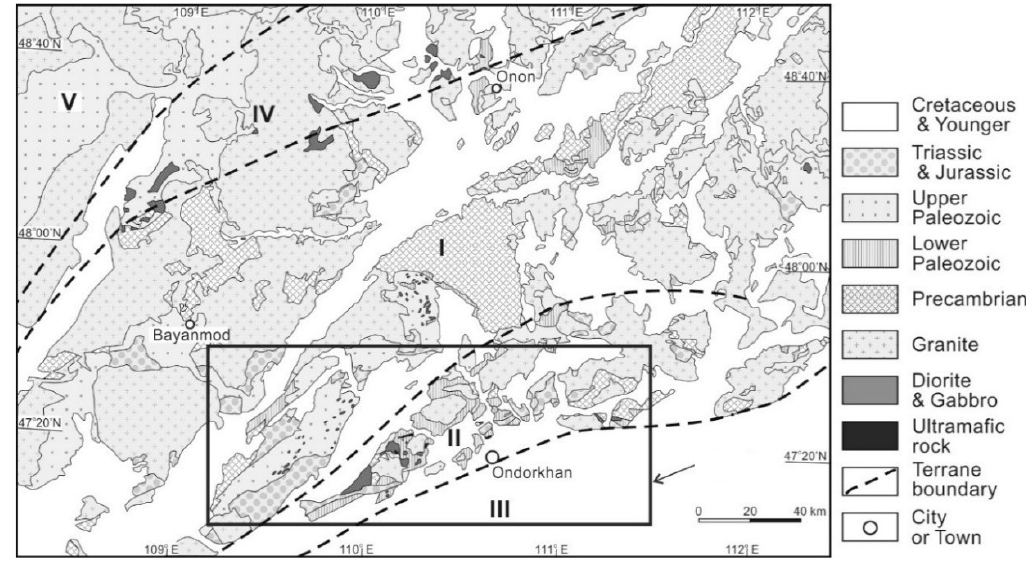
Figure3. SimplifiedgeologicalmapoftheOndorkhan-OnonregioninNEMongolia(modifiedfrom[36]). Terranes: I—Ereendavaa, II—Kherlen, III—Idermeg, IV—Adaatsag (Onon),